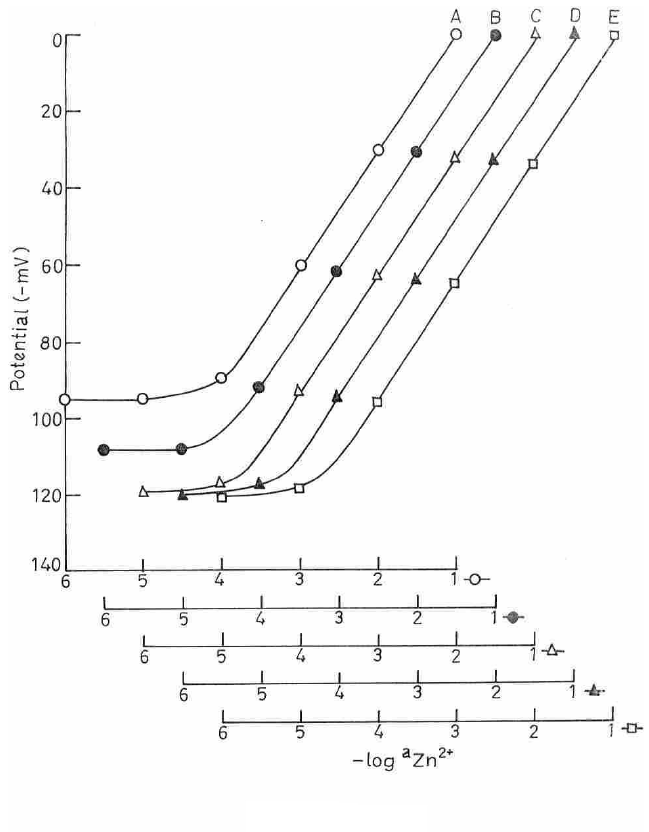
Fig.2 : Variation of potential of PVC based membranes with varying amount of ionophore (A-8.0, B-9.5, C-10.0, D-11.0, E-12.0 (%